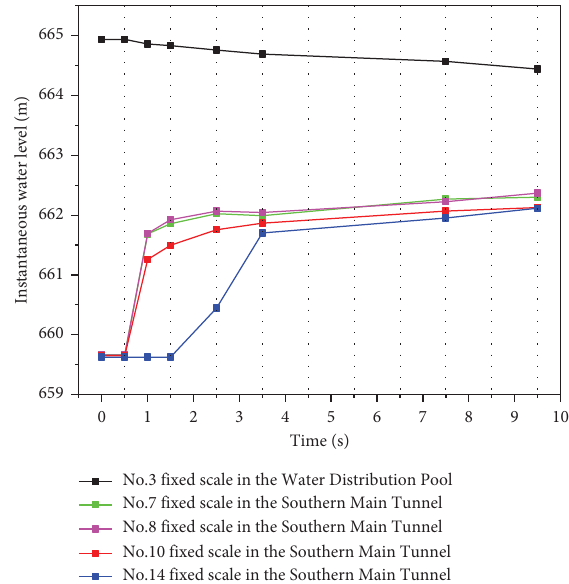
Figure 6: Instantaneous water level at each measuring point.